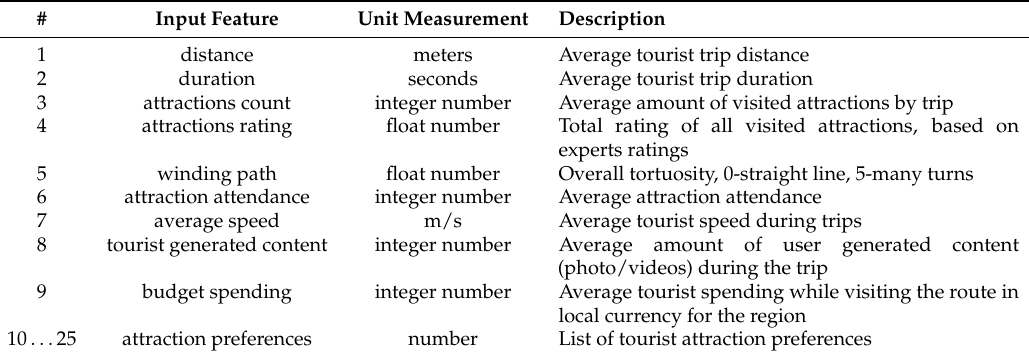
Table 3. List of the clustering neural network input layer